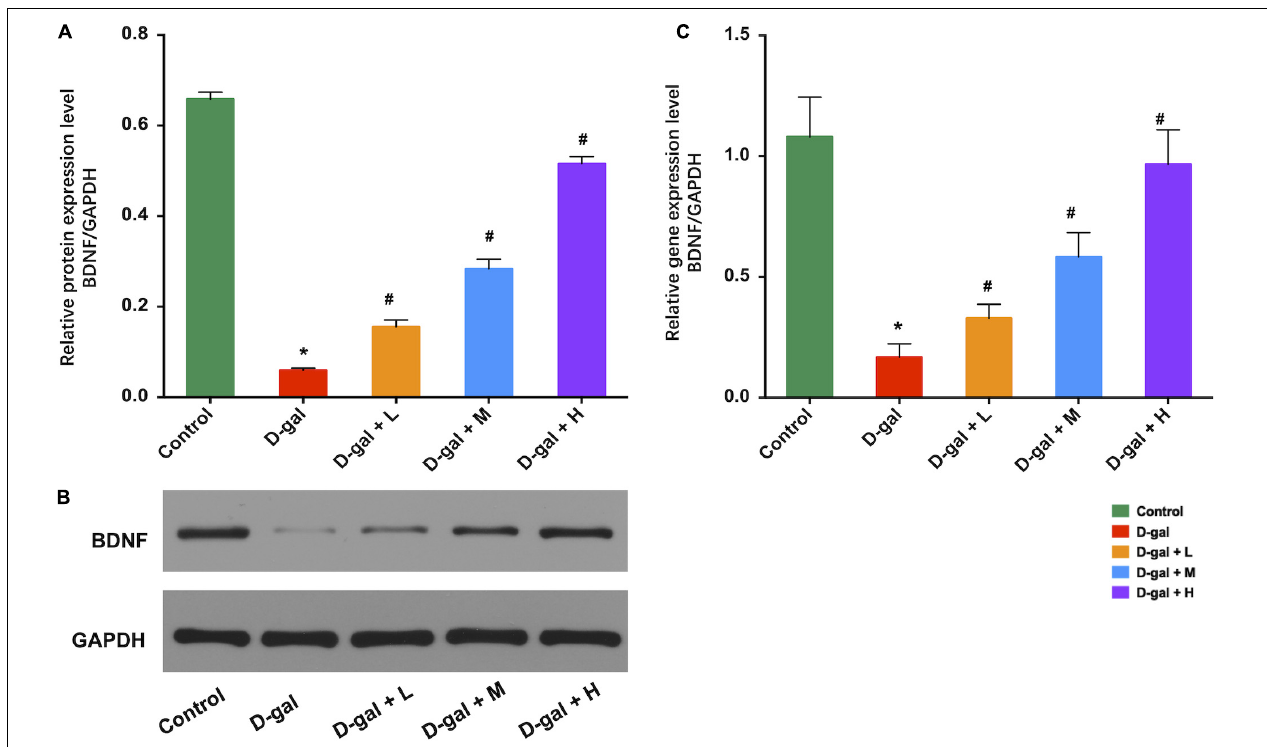
FIGURE 6 | Effects of the dietary supplement on expression of BDNF in hippocampi ( n = 8 in each group). Supplement of Dietary supplement can increase the expression of BDNF protein levels (A,B) and the expression of BDNF mRNA levels (C) in hippocampi. Values are presented as means ± SEM. * p < 0.05 when compared with the control group; # p < 0.05 when compared with the D-gal group. BDNF, brain-derived neurotrophic factor; D-gal, D-galactose; SEM, standard error of